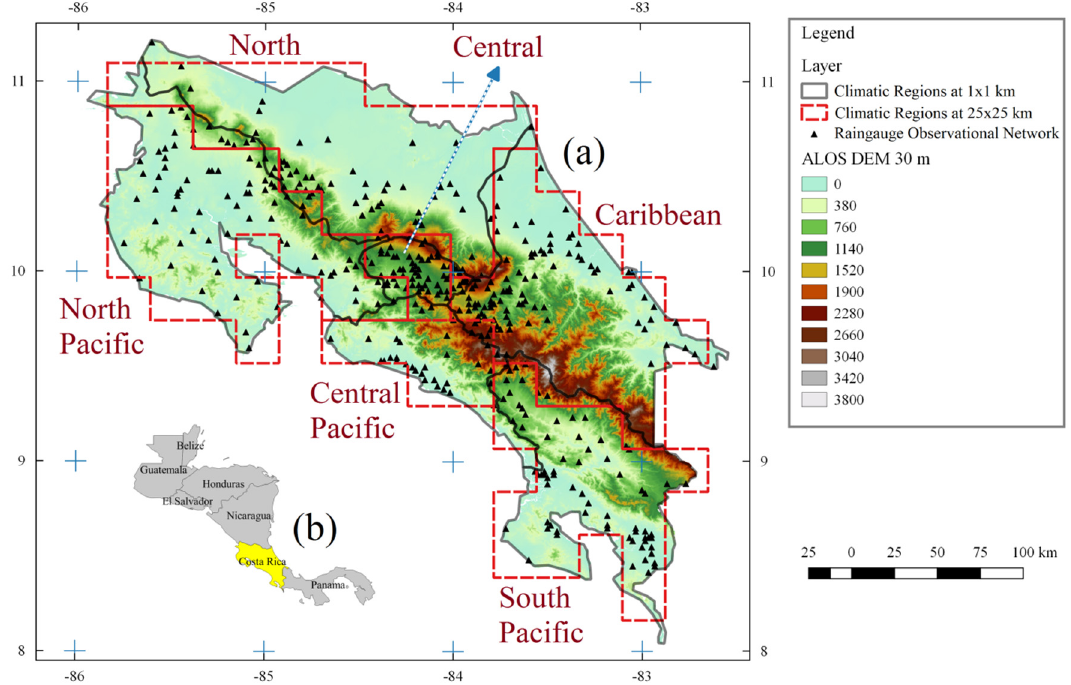
Figure 1. ( a ) Rain-gauge observational network and Digital Elevation Model (DEM) for each climatic region in Costa Rica during the period 1951–1995. ( b ) Position of the Costa Rica within the Central American isthmus.